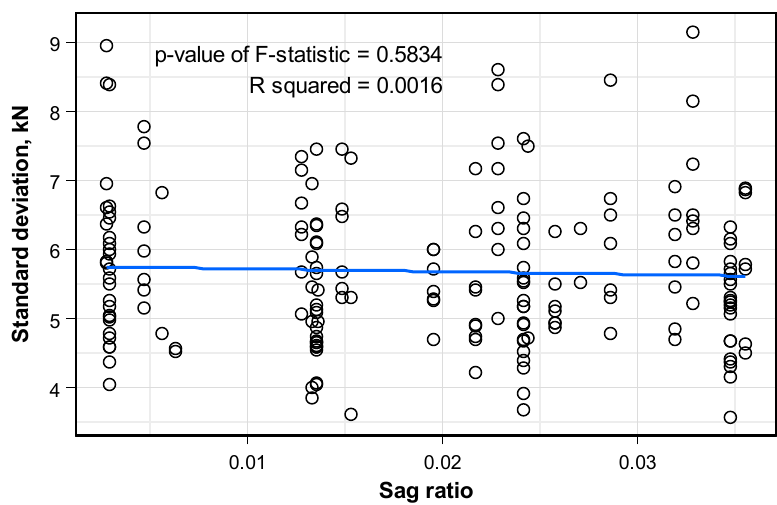
Figure 12. Distribution pattern of the standard deviation of the prestress force per anchor head according to the tendon sag ratio.